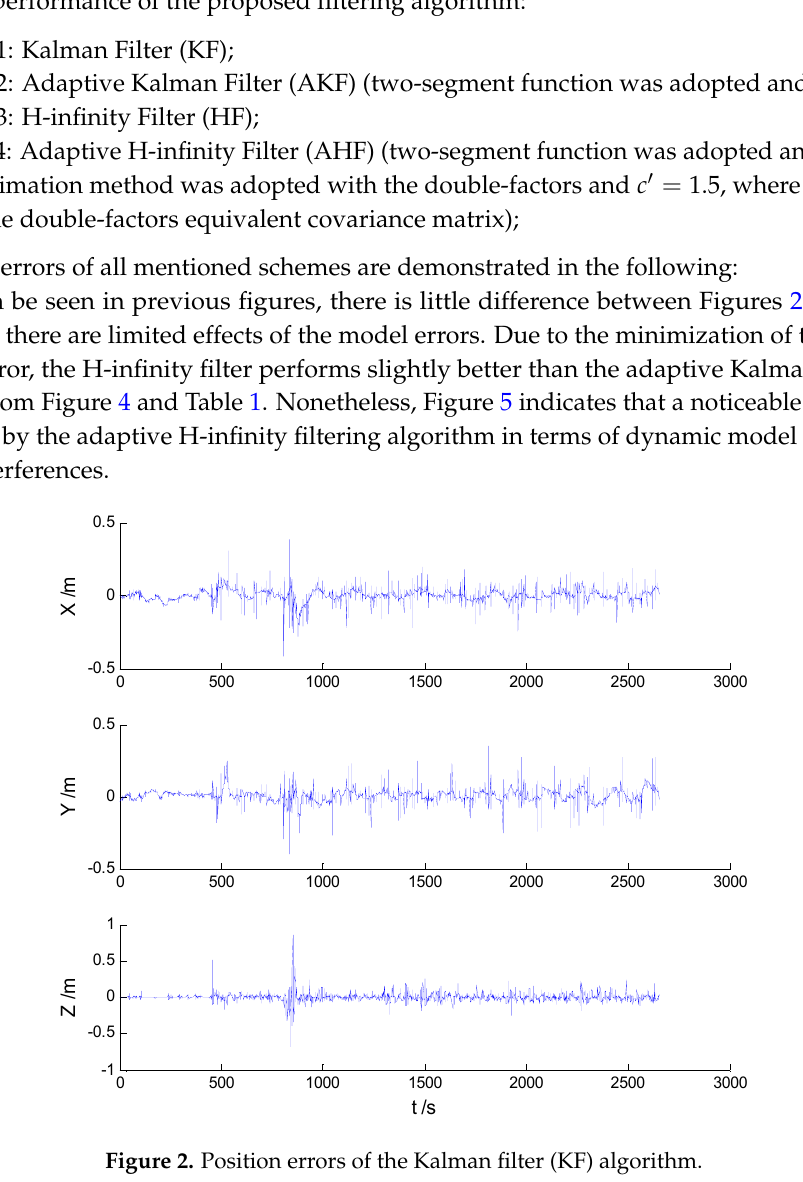
Figure 3. Position errors of the adaptive Kalman filter (AKF) algorithm.